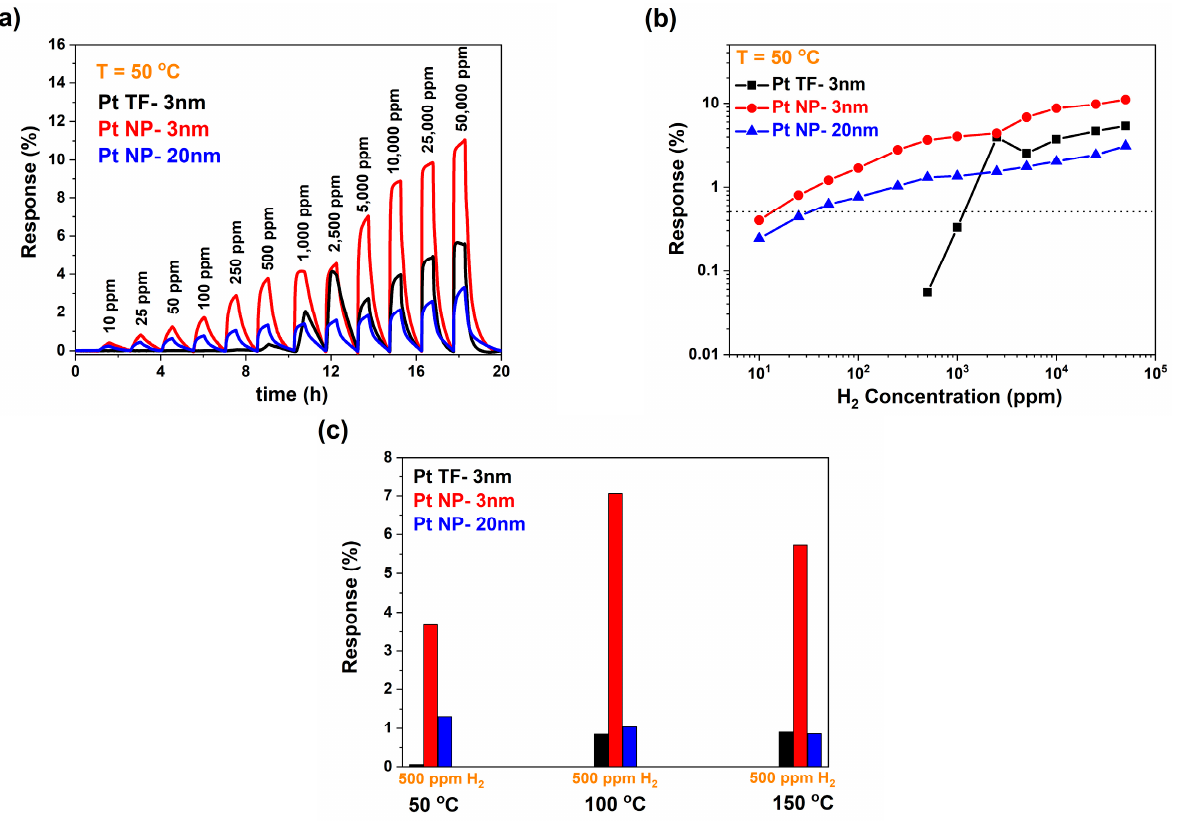
Figure 5. Response value comparisons of the Pt sensors for all concentrations at 50 °C vs. ( a ) time and ( b ) log scale concentrations. ( c ) Response value comparison of the Pt sensors only towards 500 ppm hydrogen at 50 °C, 100 °C and 150 °C.